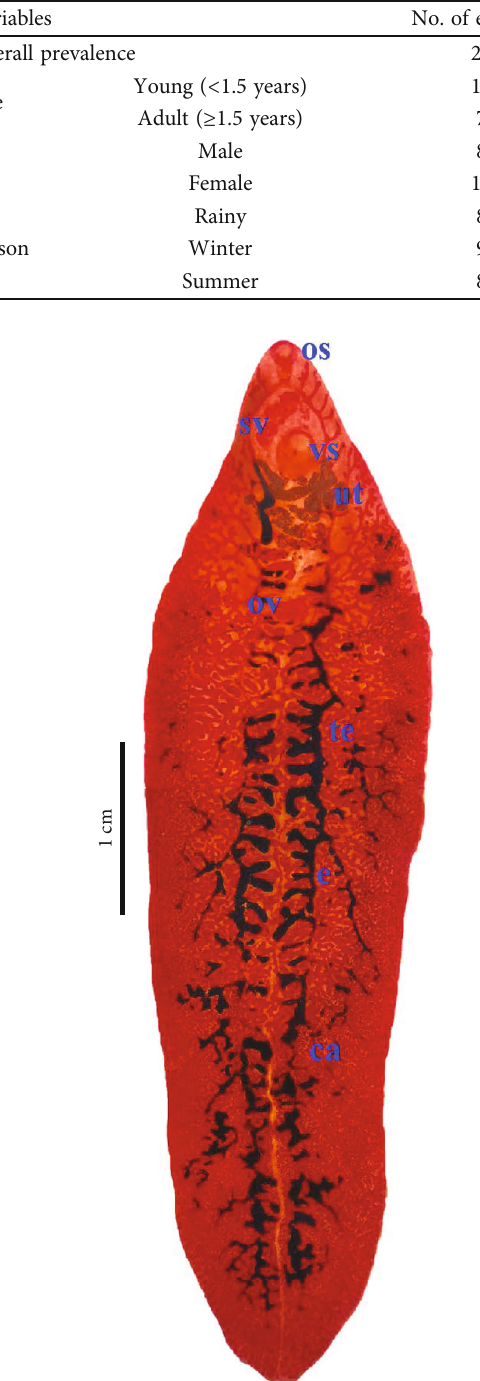
Table 1: Overall prevalence and association of fasciolosis between age, sex, and season.